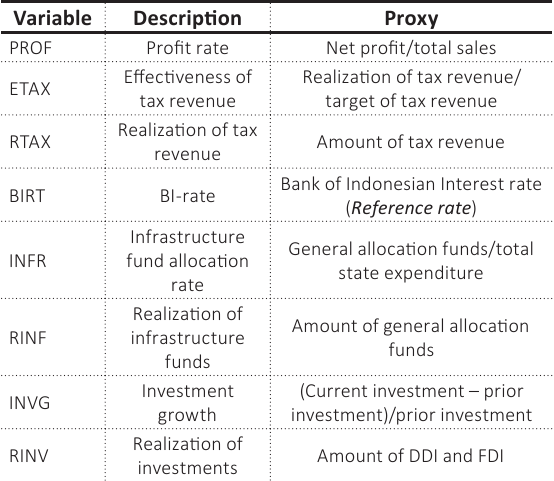
Table 1. Variable description and